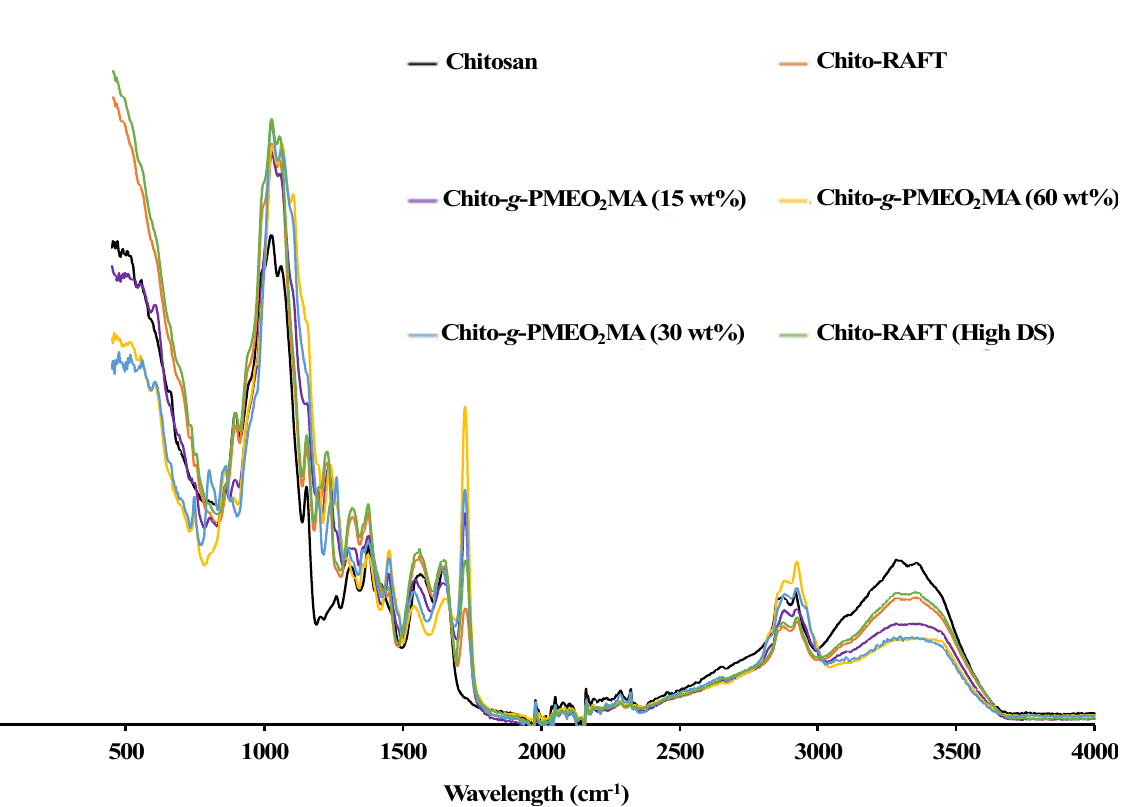
Figure 1. ATR – FTIR spectra for unmodified and modified chitosan samples. Figure 1. ATR–FTIR spectra for unmodified and modified chitosan